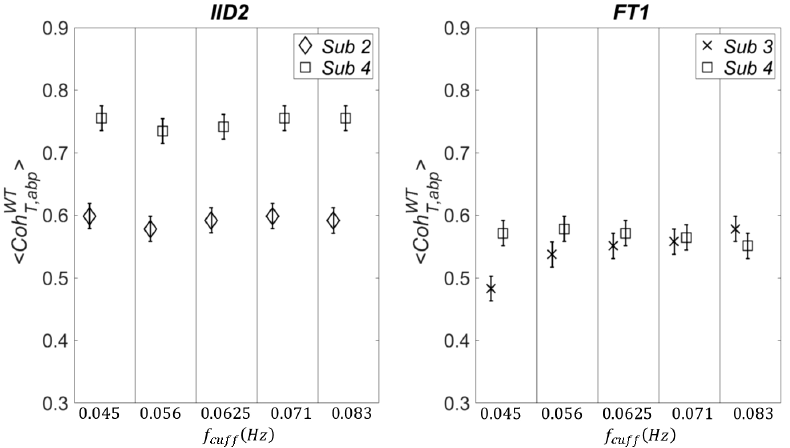
i are shown for higher statistics (1,000 pairs of surrogate data) abp